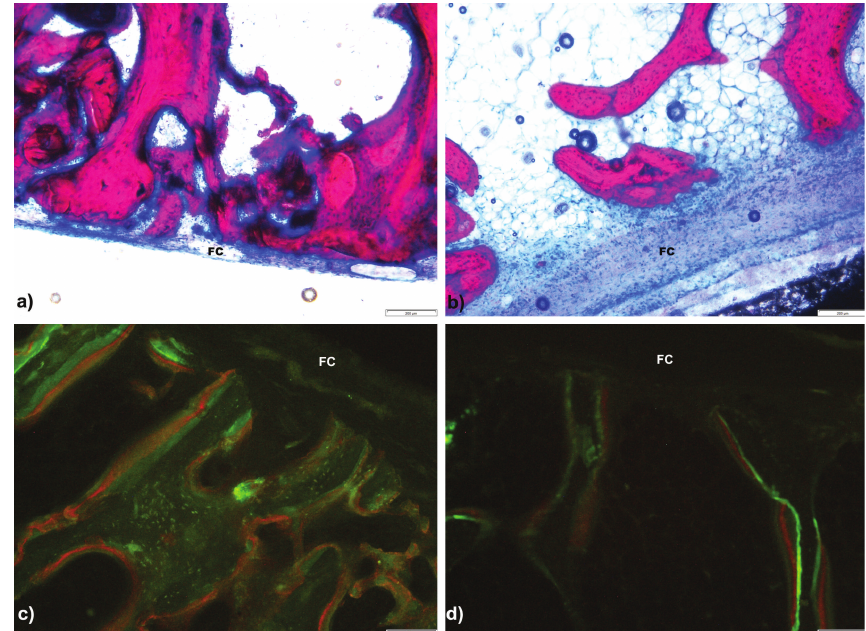
Figure 5: Microphotograph of nondecalcified sections. On top, (a) shows Z3 areas of actuator and (b) shows static control, both implanted in the same position in tibia. On bottom, Z2 areas showing increase labeled area in (c) femoral actuator when compared to contra lateral (d) static control. A fibrous capsule (FC) was present on the bone/film interface. Scale bar represents 200 µ m.